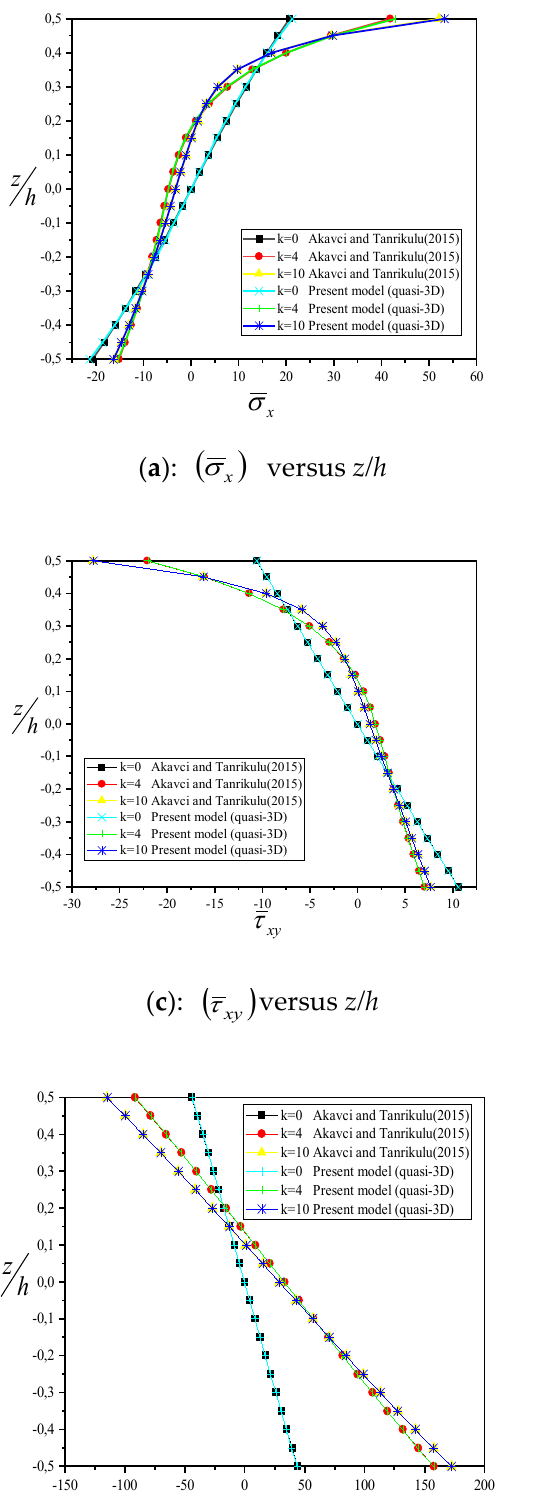
versus z/h ( ) (cid:0) (cid:1) wu , and stresses σ x , σ z , τ xy , τ xz